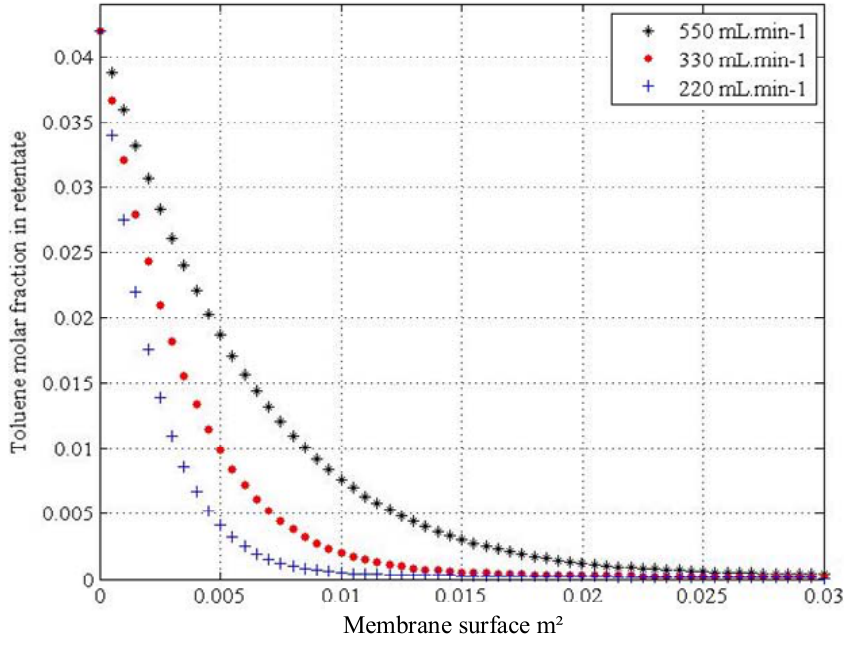
Figure 6. Variation of the toluene molar in retentate as a function of the membrane surface at three different flow rates. Upstream pressure, 1 bar (10 5 Pa); downstream pressure, 5 mbar (500